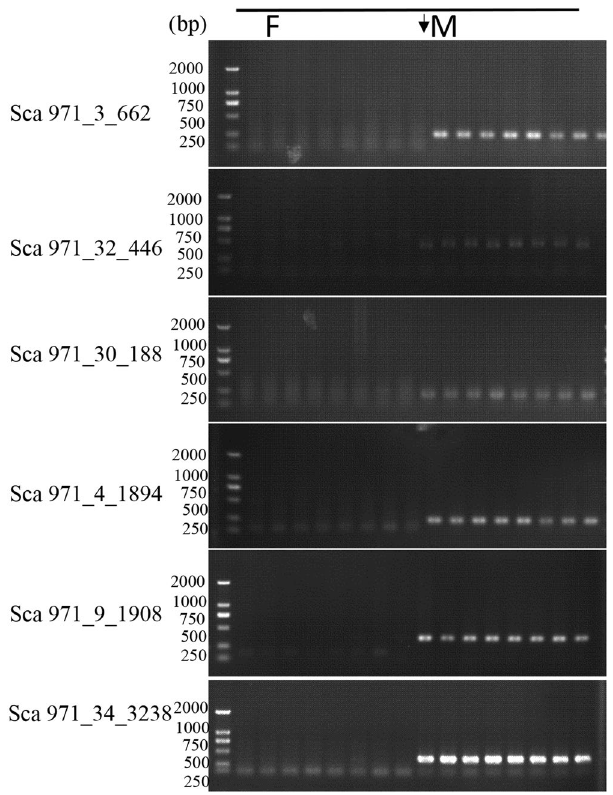
Figure 4. PCR tests for fragments that distributed in Sca971 in wild grass carp individuals. Male specificity was defined as the occurrence of a clear amplicon of a distinct size in males but not in females. The DL2000 DNA Markers are loaded in the Lanes. The results showed that all the six sequences of Sca971 were only amplified in wild male grass